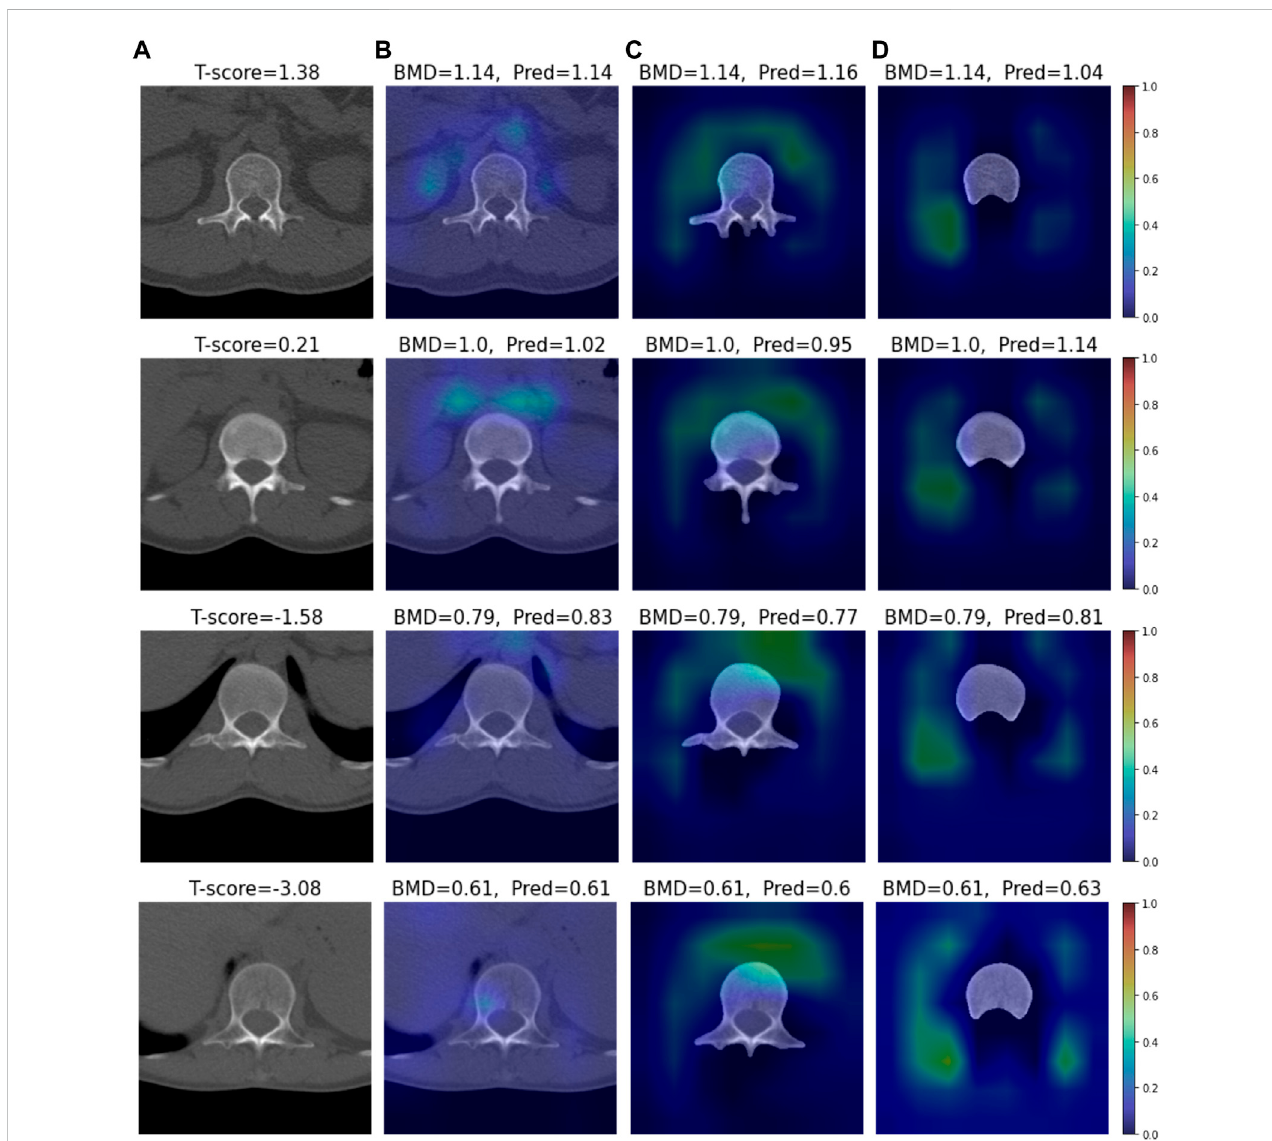
FIGURE 6 Visual XAI results (4 test samples) using Grad-CAM. The results of every sample are represented by every row. Every row, (A) represents the cropped CT image.AT-scorevalueisplacedatthetopofeveryimage. (B – D) displaytheheatmapsuperimposedonthecroppedimageorbone-segmentedimage. (B – D) show Grad-RAMP results in Case 1, Case 2 and Case 3, respectively. “ BMD ” and “ Pred ” placed at the top of every image denote the reference and predicted values,